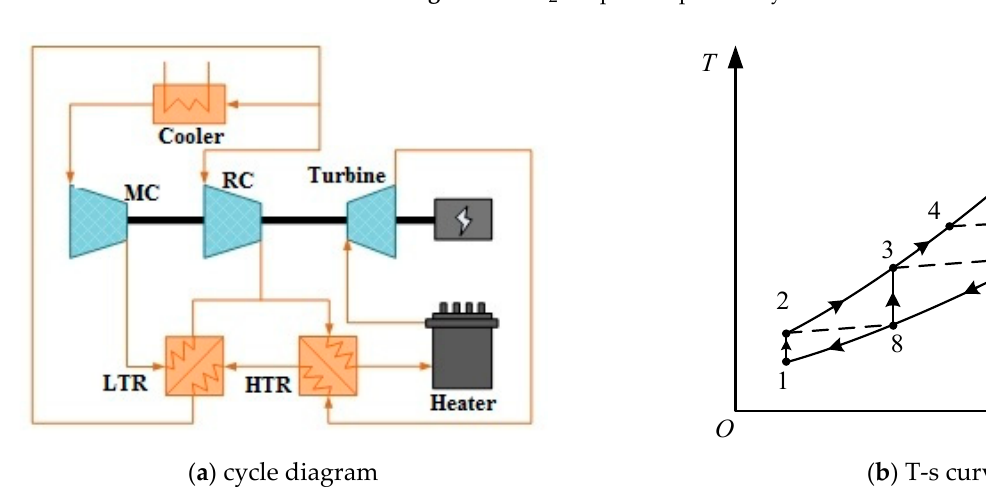
Figure 2. SCO 2 simple recuperated cycle.